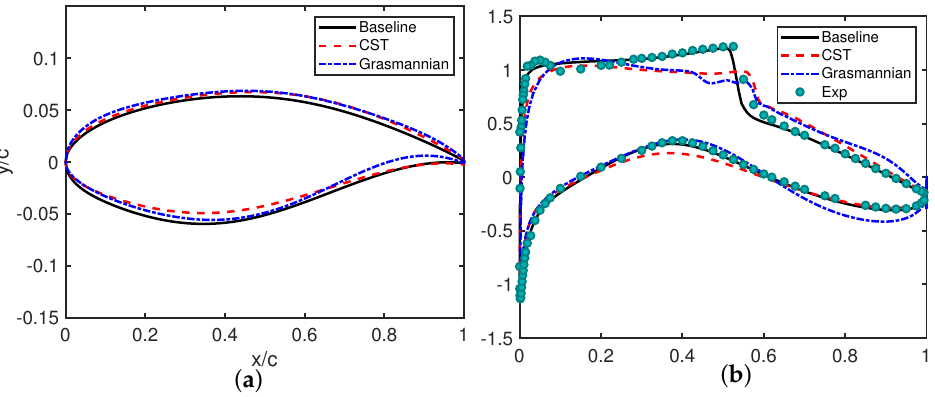
Figure 8. Comparison of the geometry and pressure coefficient of the transonic case: ( a ) Airfoil shape; and ( b ) Pressure